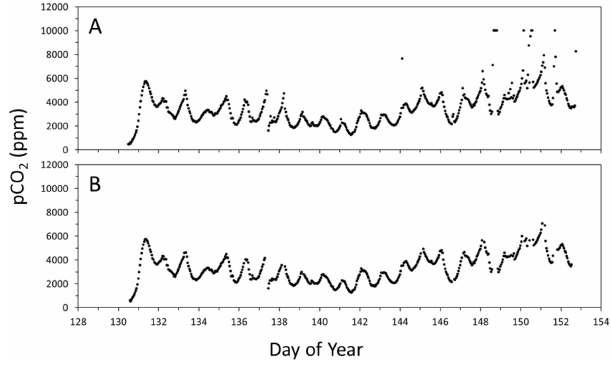
Figure 8. Example of long-term monitoring of p CO 2aq at 1h inter- vals in a small shallow boreal wetland pond (mean depth 1m). Panel (a) shows raw data indicating spikes in the data most likely due to condensation events (or possibly related to animals temporary visit- ing the chambers; insects, frogs, etc.), particularly towards the end of the deployment. Panel (b) shows the same data as in (a) after a simple filtering procedure, removing data points that were more than 10% greater than the − 4 to + 4h median of surrounding the data